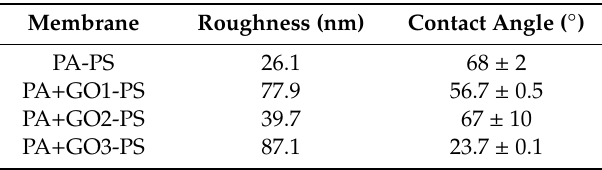
Table 3. Surface properties of the membranes.